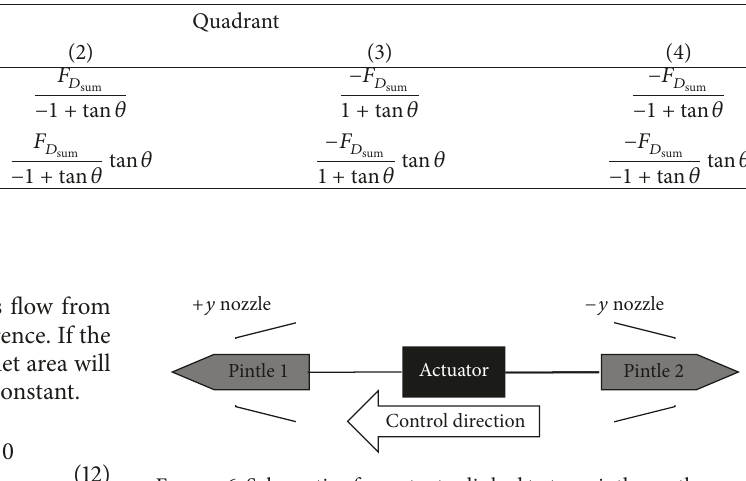
Figure 6: Schematic of an actuator linked to two pintles on the same